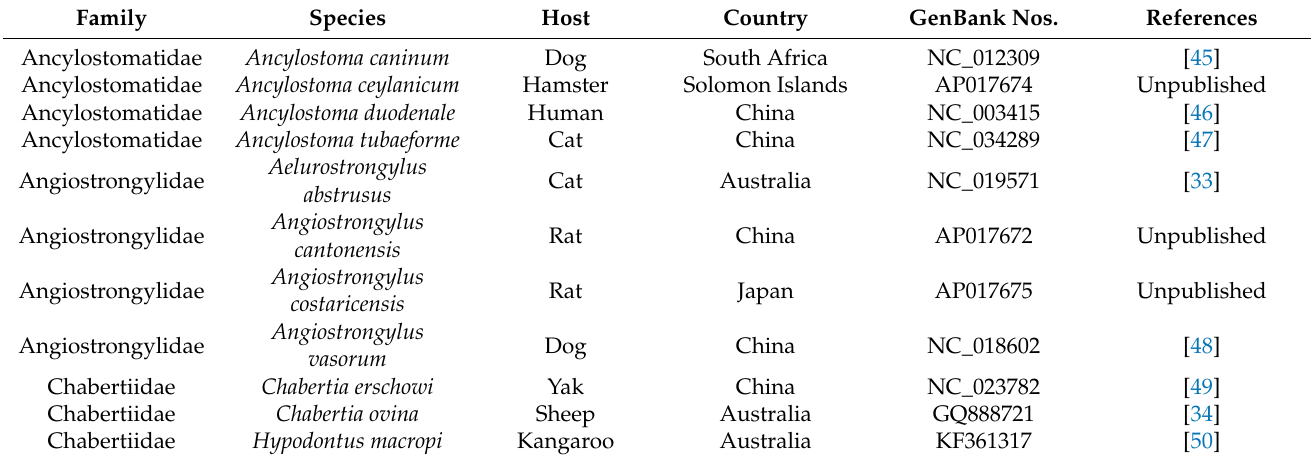
Table 2. Summary mtDNA information included in this